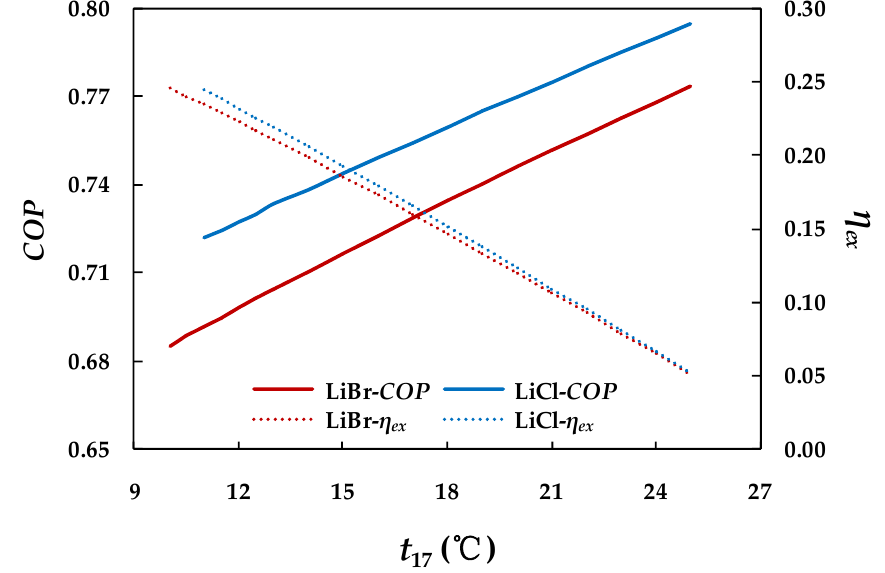
Figure 19. Variation of COP and exergy efficiency with the chilled water inlet temperature for the two absorption chillers.